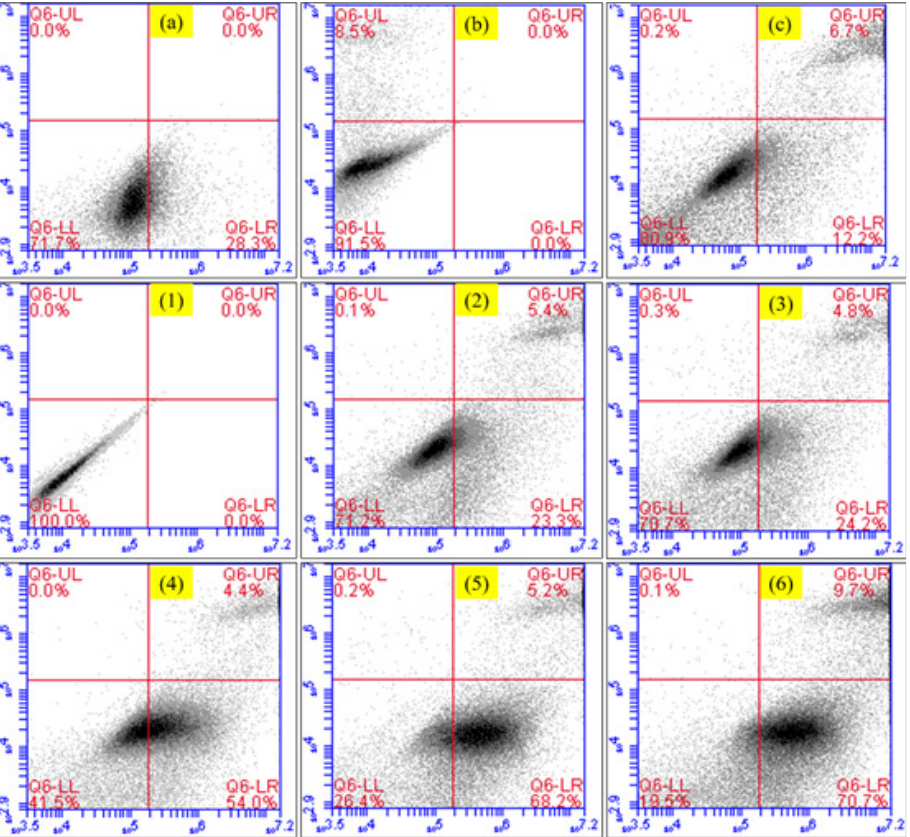
Figure 3: Cells were stained with Annexin V- Alexa Fluor TM 488 for verifying the apoptotic or necrotic cell ratio. METH induced U-118 MG cells apoptosis. (a) Alexa Fluor TM 488 positive control; (b) Annexin V positive control; (c) double staining positive control. (1) Natural group; (2) METH